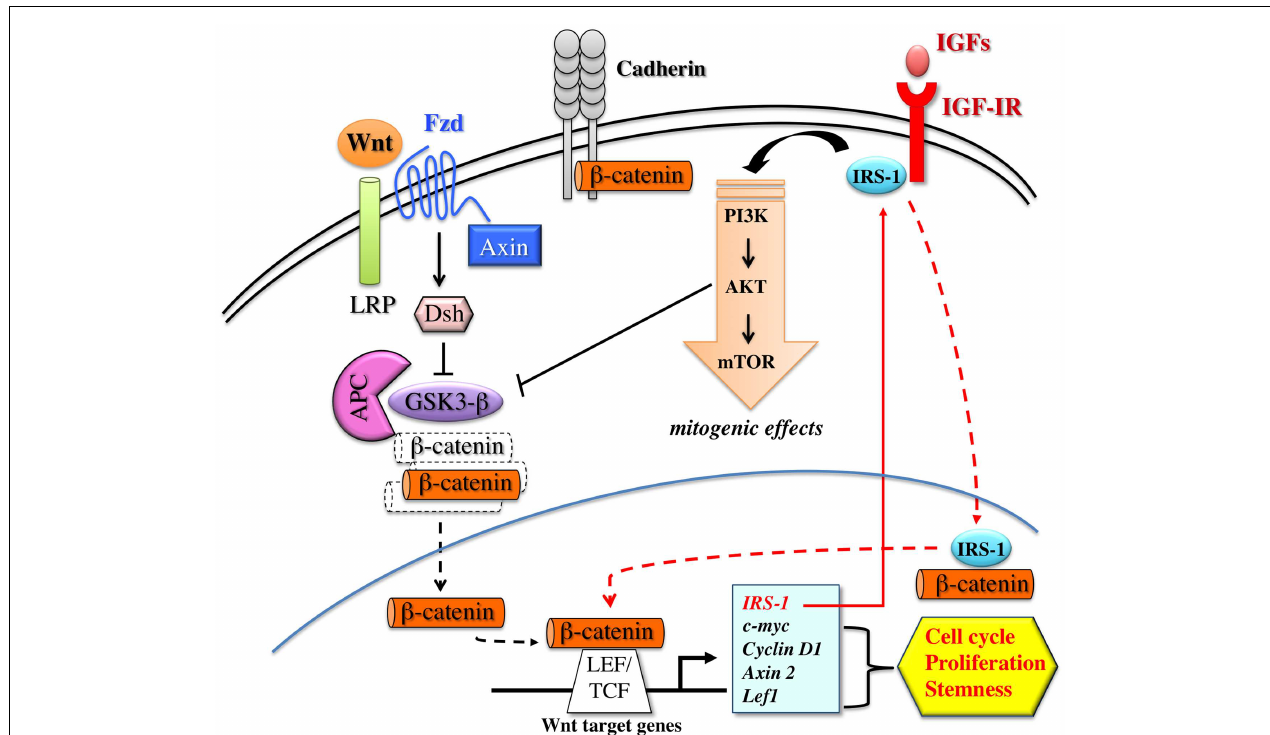
efficient transcription of genes that are important regulators of cell proliferation, cell cycle progression, and stem cell fate.Wnt target genes include IRS-1, which, in turn, amplifies the IGF-IR/PI3K pathway and its mitogenic signals. IRS-1 contributes to β -catenin stabilization by activating PI3K pathway and inducing GSK3 β inhibition. Furthermore, after IGF-I stimulation, IRS-1 partially translocates into the nucleus where it binds to and co-localizes with β -catenin, further contributing toTCF dependent transcription. β -catenin also exists in a cadherin-bound form and regulates cell–cell